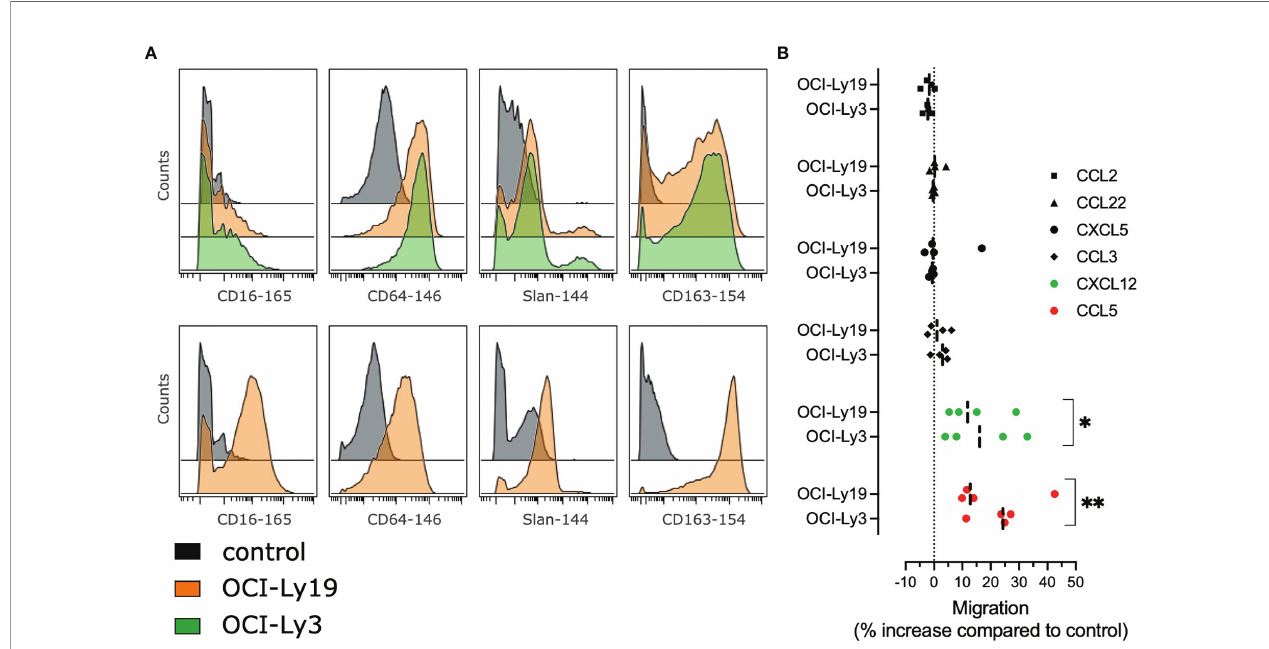
FIGURE 4 | Tumor cells supernatants polarize monocytes with higher migratory abilities. (A) Monocytes from healthy donors (n = 2) were treated with OCI-Ly3, OCI- Ly19 supernatant, or vehicle as control. Overlay histograms represent mean marker intensities for selected markers. Monocytes treated with vehicle (grey), OCI-Ly19 supernatant (orange), or OCI-Ly19 supernatant (green). Top: experiment 1. Bottom: experiment 2. (B) Migration assay for HD monocytes (n = 4) cultured or not with OCI-Ly3 and OCI-Ly19 supernatant in response to CCL2, CCL3, CCL5, CCL22, CXCL5, and CXCL12. Wilcoxon matched-pairs signed rank test were used to compare tumor-conditioned monocytes migration to the control condition (OCI-Ly medium). *P < .05, **P < .01